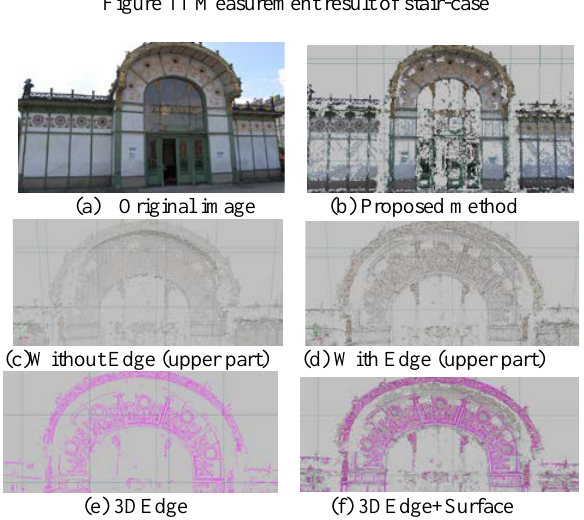
Figure 12. Measurement result of an architectural structure